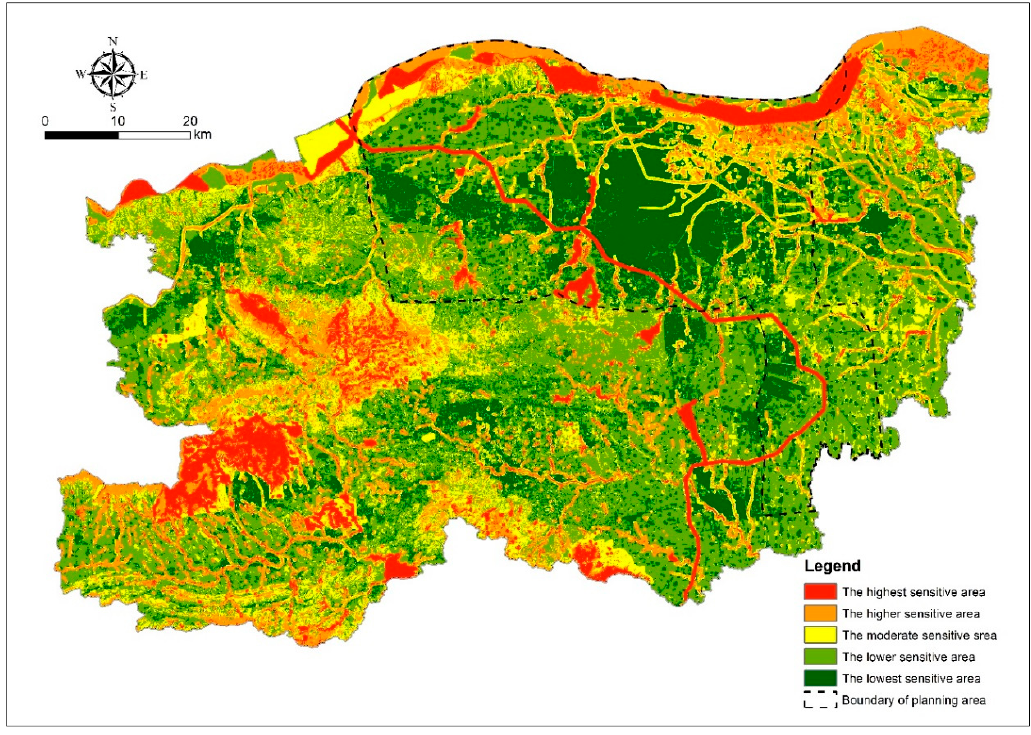
Figure 4. Comprehensive ecological sensitive area in Zhengzhou. Table 3. Statistics on the sizes of ecological sensitive areas and their main distributions.